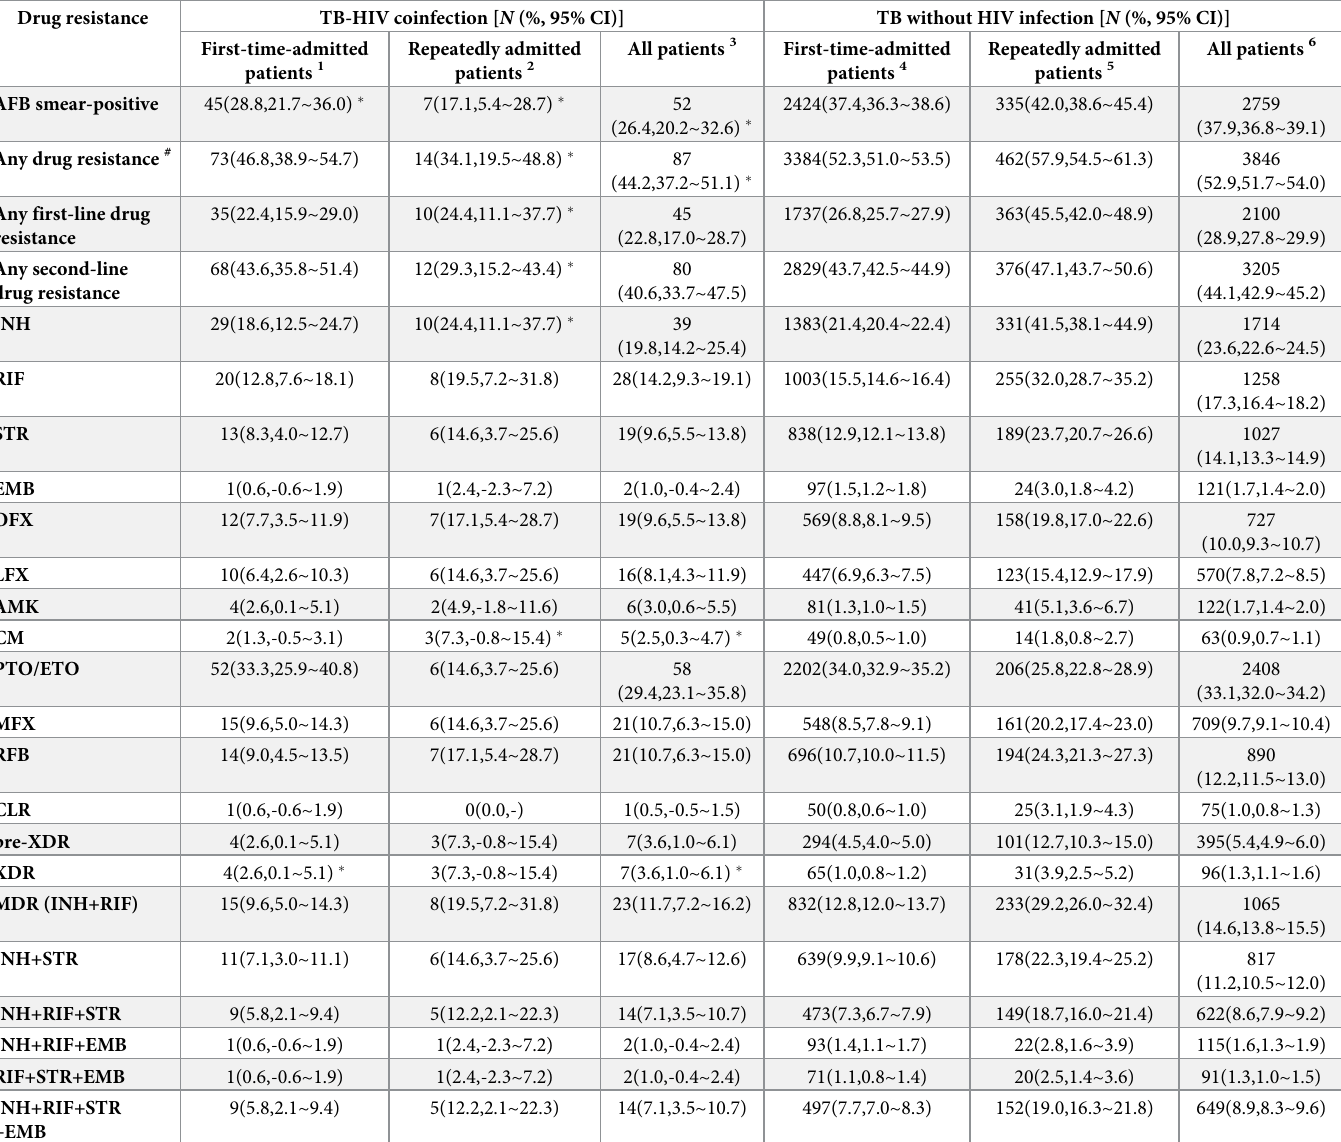
Table 1. Drug resistance patterns of M . tuberculosis in the TB-HIV coinfection group and the TB without HIV infection group. Drug